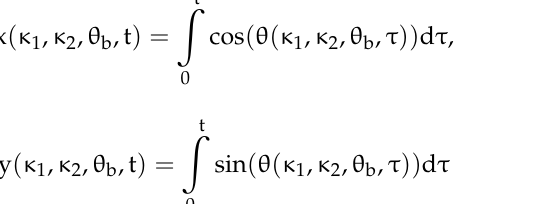
The coordinates of centre S(x S , y S ) and the radius of circle R in the global coordinates system as well as the angle α are the initial data.